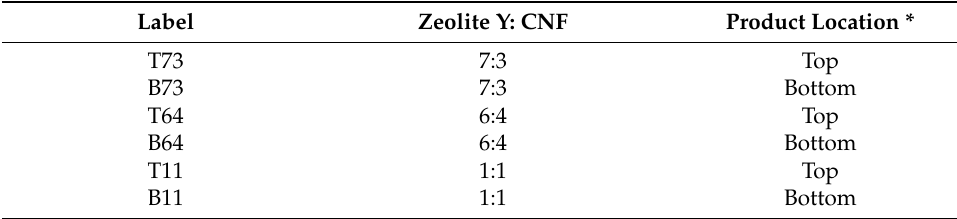
Figure 1. Schematic representation of the procedure followed to prepare nanozeolite Y. Table 1. Summary of the zeolite Y to CNF ratios used in this